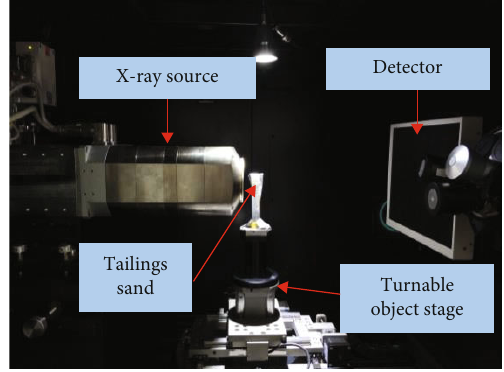
Figure 6: Micro-CT scanning of tailing